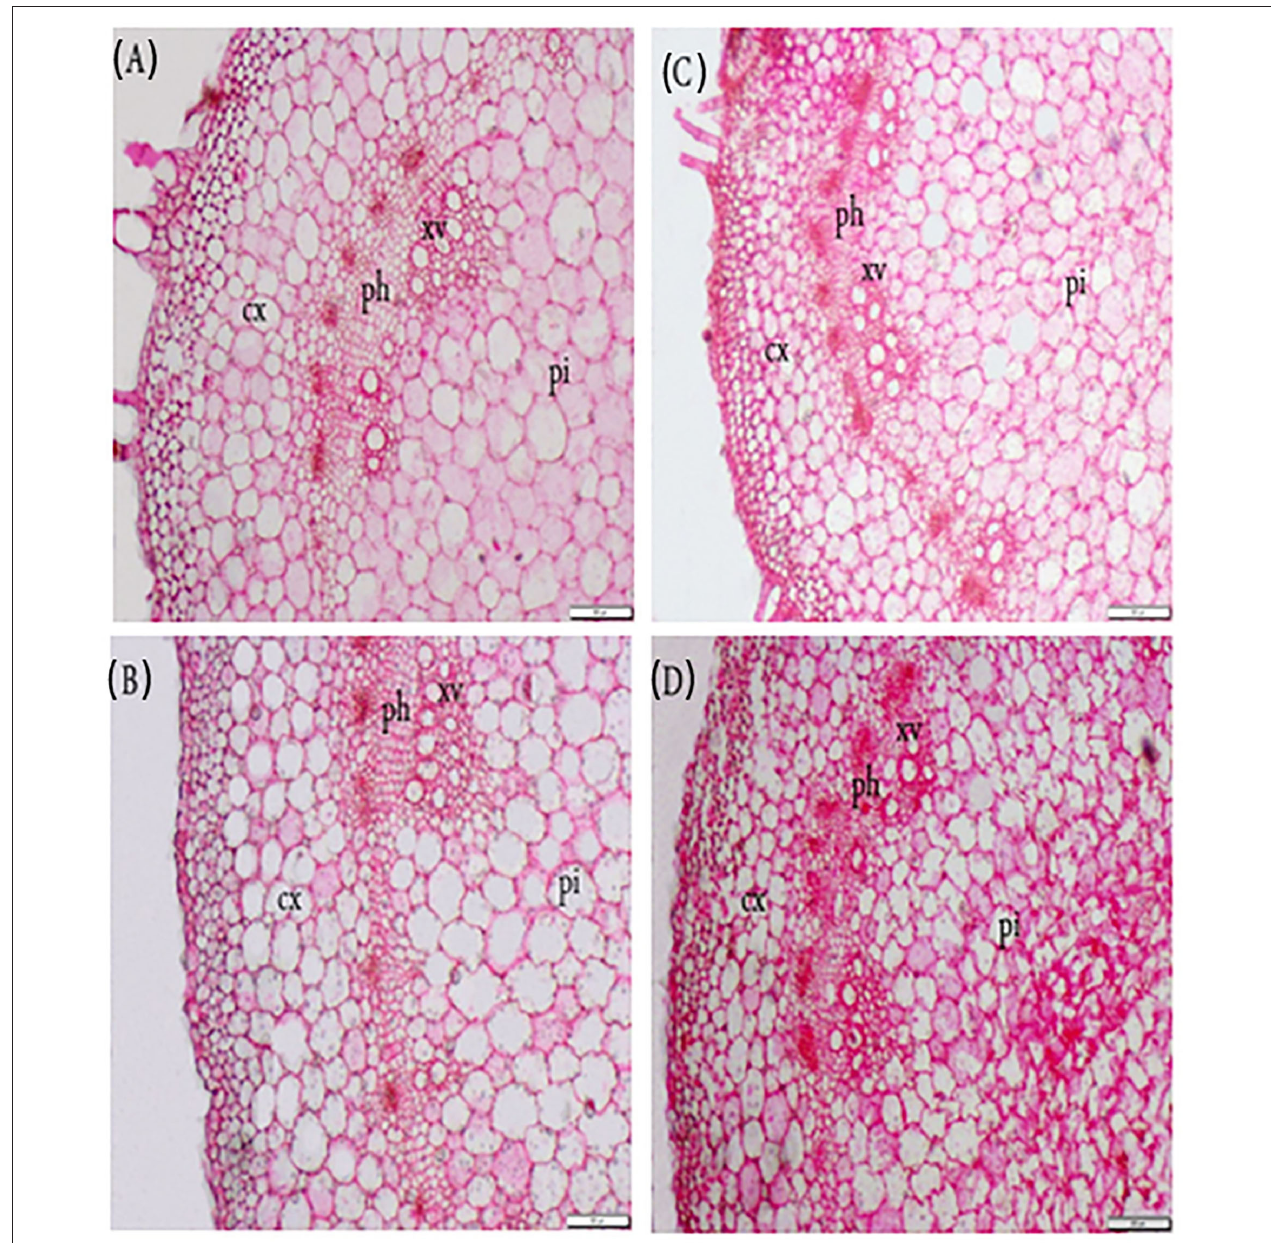
FIGURE 3 | Exogenous application of folic acid (FA) and saline water (SW) on the stem anatomical structure of Plectranthus amboinicus . (A) FA 0 SW 0 ; (B) FA 50 SW 0 ; (C) FA 0 SW 102 ; and (D) FA 25 SW 102 . Cx, cortex; ph, phloem; xv, xylem vessels; pi, pith; SW0, 0mM NaCl; SW102, 102mM NaCl; FA0, 0 µ M FA; FA 25, 25 µ M FA; FA50, 50 µ M